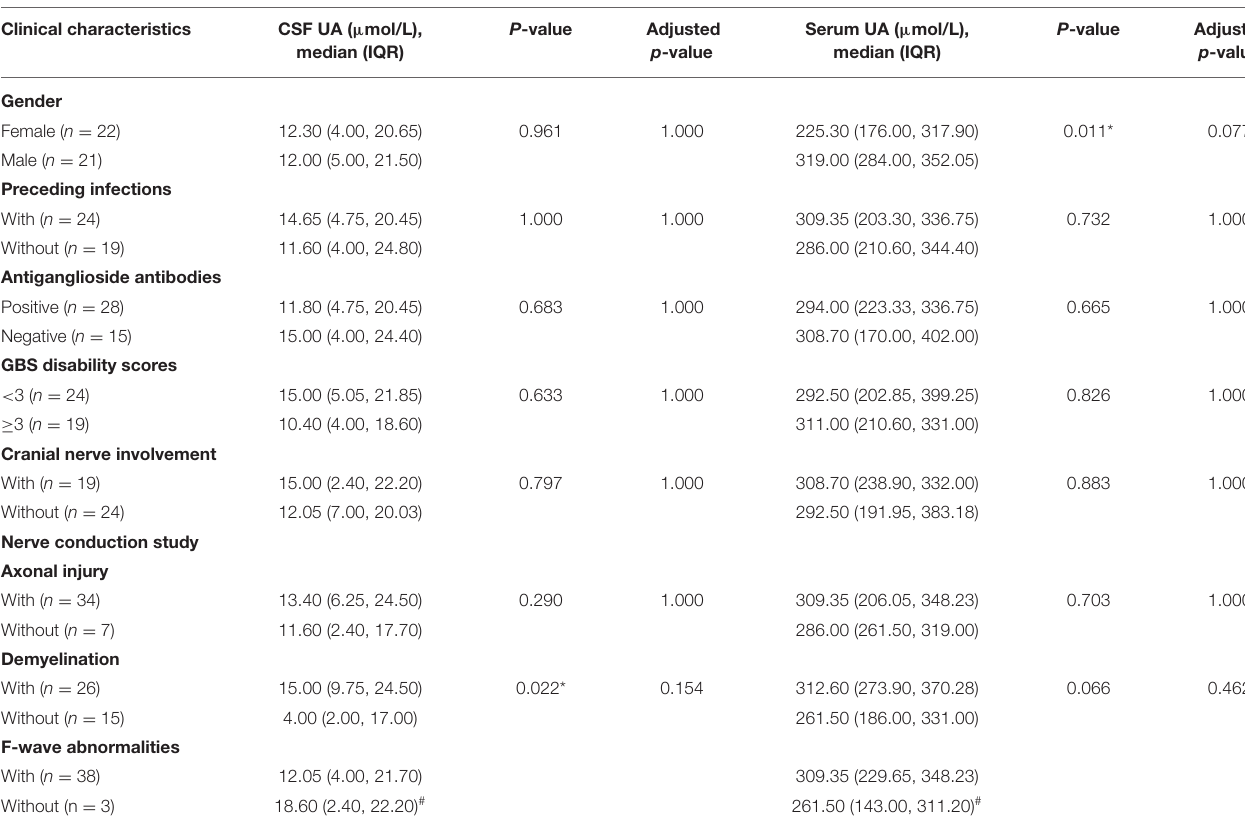
TABLE 2 | CSF and serum UA levels in GBS patients with different clinical characteristics. Clinical